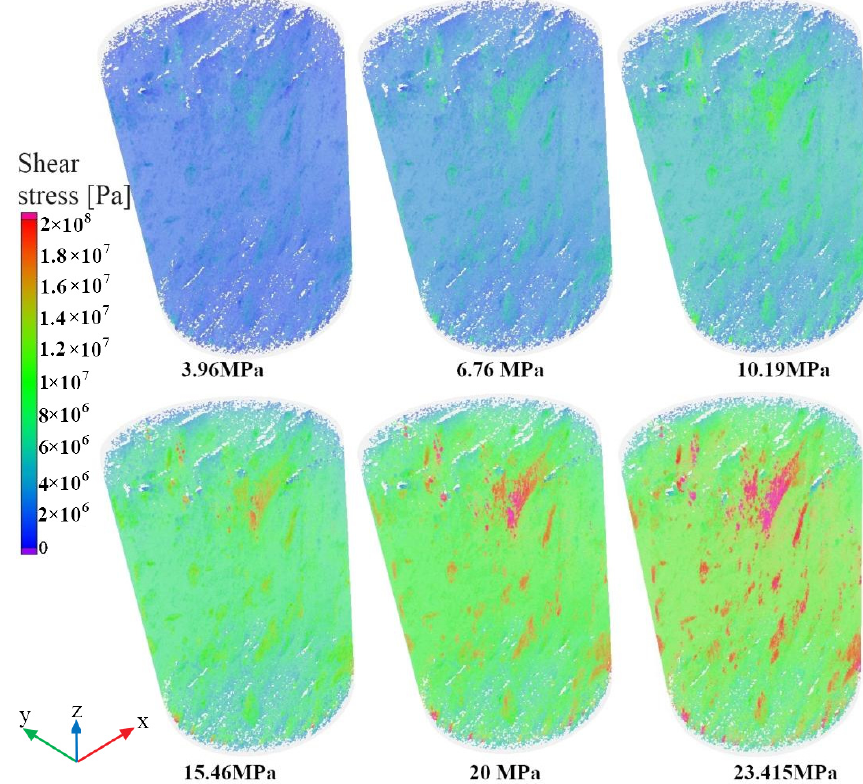
Figure 14. Simulated 3D shear stress field under different loads.